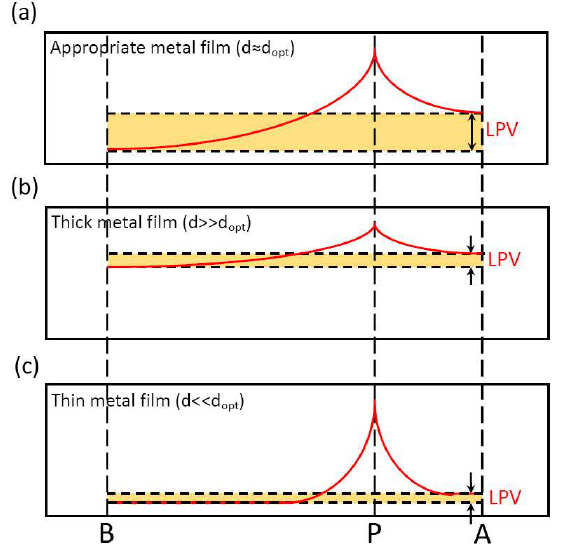
Figure 15. Diagram of metal thickness effect of LPE in MS structure. The red curves represent the distribution of density of laser-induced electrons. (a – c) shows the situations with three different metal